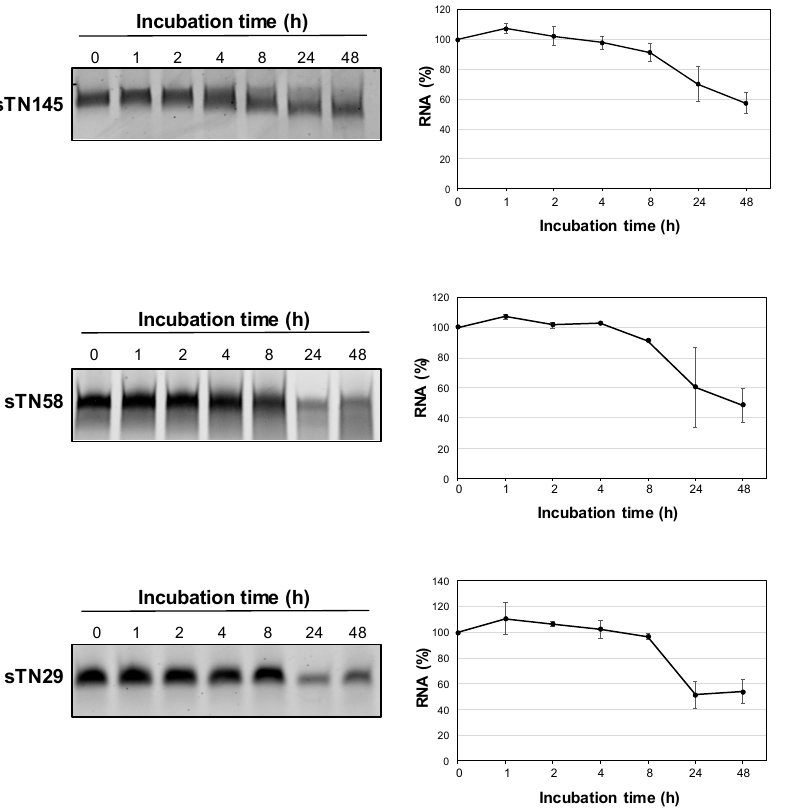
Figure 6. In vitro serum stability analysis of sTN145, sTN58 and sTN29 aptamers. ( Left ) Denaturing PAGE of the short aptamers following incubation with 80% human serum at the indicated times. Depicted results represent one of three typical experiments performed. The 3 short aptamers contain 2 ′ F-Pys in the entire sequence to increase nuclease resistance. ( Right ) Band intensity was quantified using ImageJ (v1.46r) at each time point and expressed as a percentage with respect to time 0 RNA. Note that time 0 was taken after 1 h incubation with proteinase K. Data shown are mean ± SD of three independent experiments.